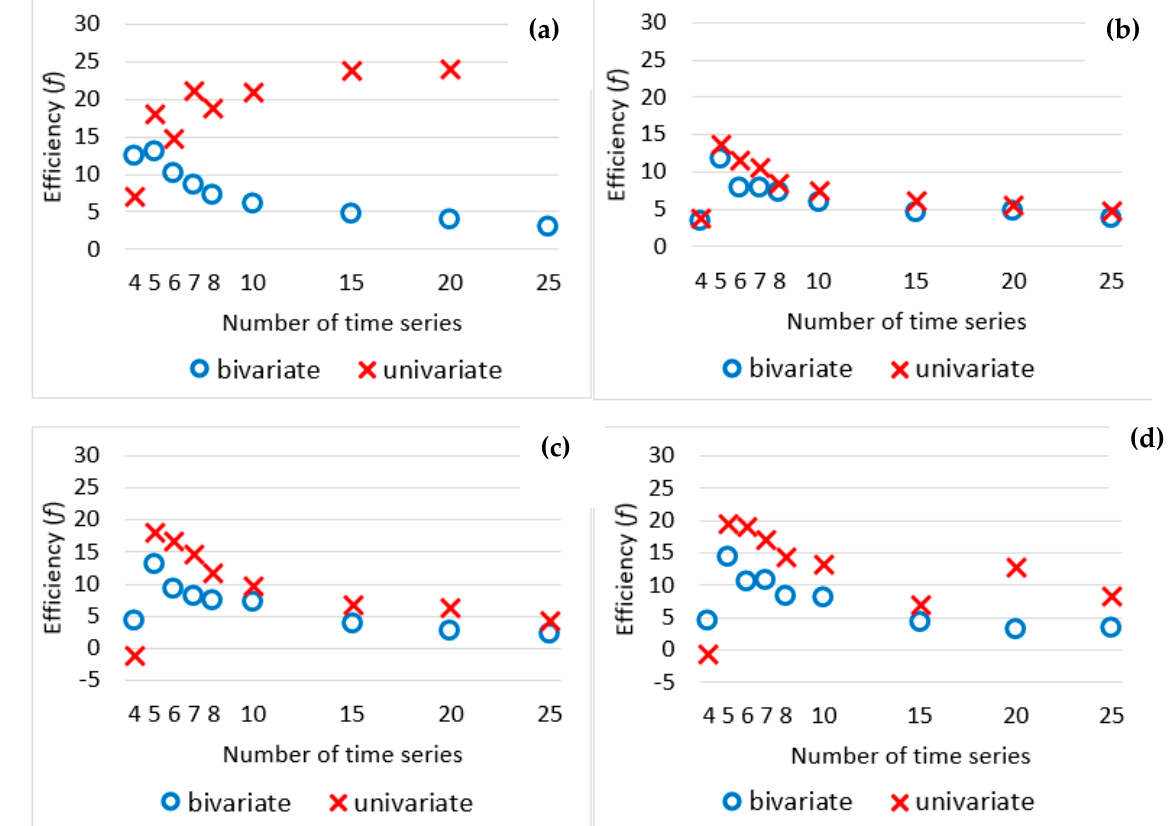
Figure 2. Efficiency of metadata use ( f ) in the function of the number of time series in networks, according to bivariate and univariate ACMANT homogenization. Upper left panel ( a ) CRMSEm, upper right panel ( b ) CRMSEy, bottom left panel ( c ) Trend bias for individual time series (Trbias), bottom right panel ( d ) Network mean trend bias (Trnetb).